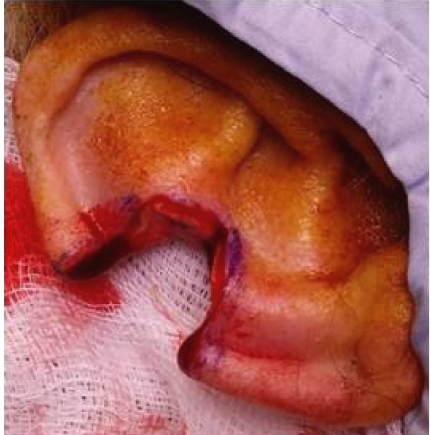
Figure 2: Clinical photograph showing appearance of the right upper pinna following wedge excision of the initial one-centimetre nodular lesion with 4-millimetre resection margins.